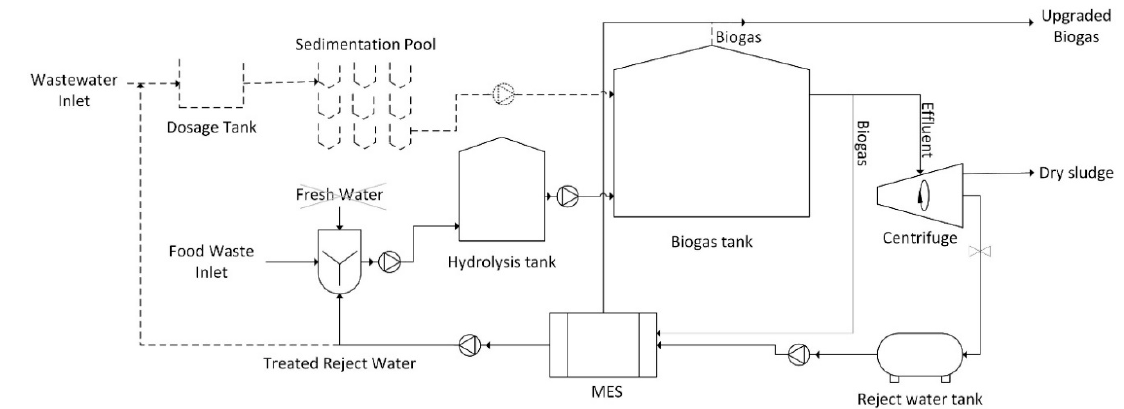
Figure 9. Proposed (generalized and simplified) AD-MES integrated treatment plant setup.